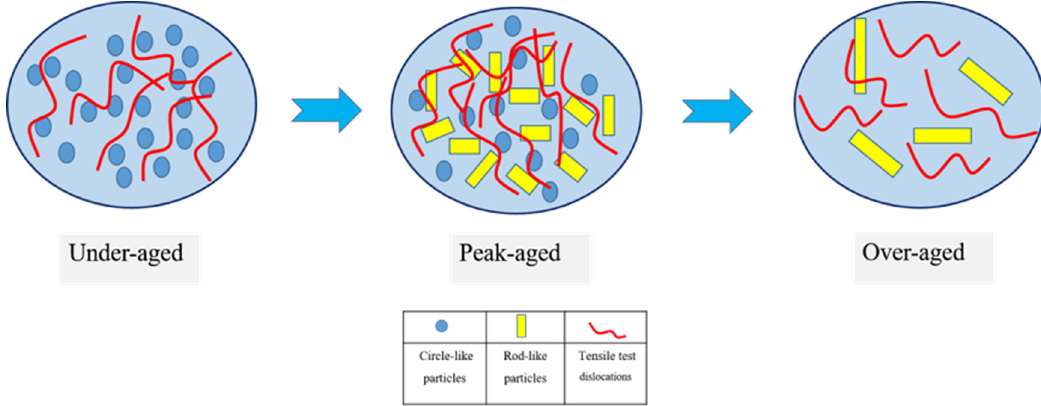
Figure 8. Schematic illustration showing the effects of precipitates on hindering dislocations of the Ag-bearing alloy.